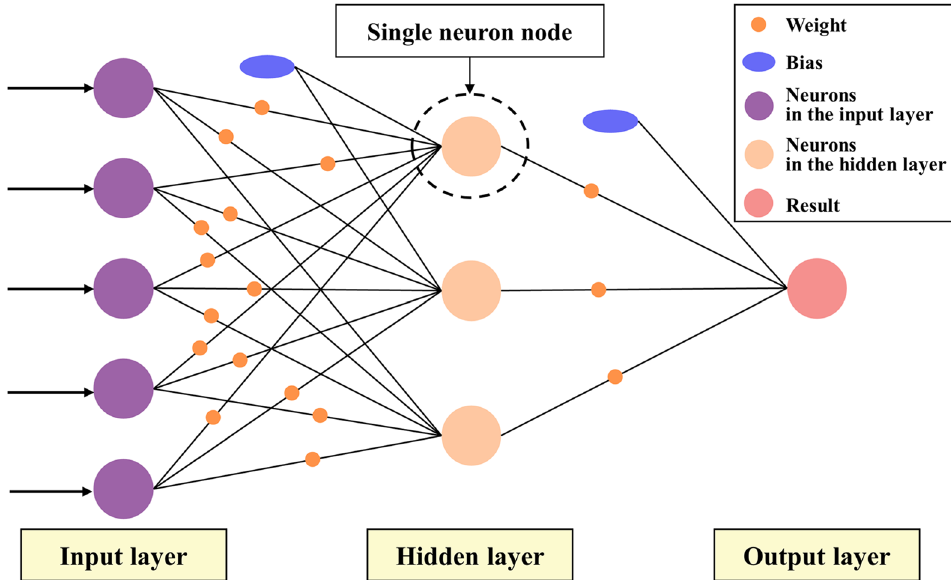
Fig. 7 Artificial neural network model (modified from Aleotti et al.